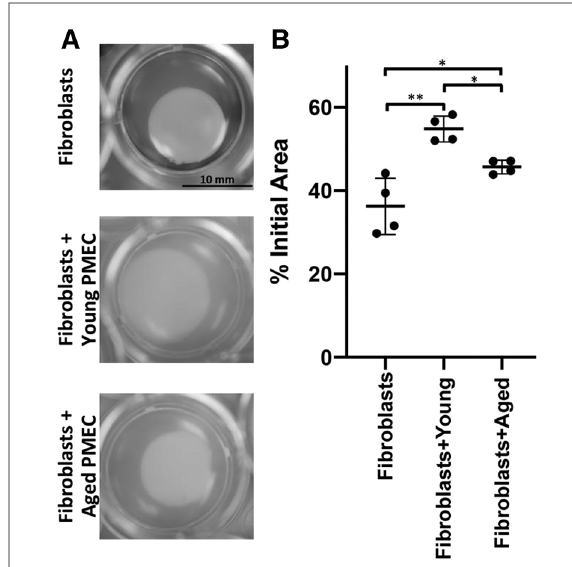
FIGURE 3 Impact of esophageal epithelial cells from young and aged mice upon fi broblast contraction. Primary murine esophageal epithelial cells (PMECs) were isolated from young or aged wild type C57/ BL6 mice and passaged several times prior to experiment. Fetal esophageal fi broblast cell line FEF3 was co-cultured with young or aged PMECs in collagen plug contraction assay for 72 h. ( A ) Representative images for contraction of collagen plugs following 72 h of fi broblasts alone and co-cultured with aged or young PMECs. Images were captured at 72 h using an Olympus MVX10 microscope (0.63X objective). ( B ) Quantitative analysis of fi broblast-mediated gel contraction. Relative plug area was obtained by measuring fi nal dimensions in comparison with initial area. Each dot represents mean for one of four independent experiments performed in triplicate and bar represents mean±SD. Two-way ANOVA testing with Tukey ’ s correction was used to determine signi fi cance. * p ≤ 0.05; ** p ≤ 0.001.